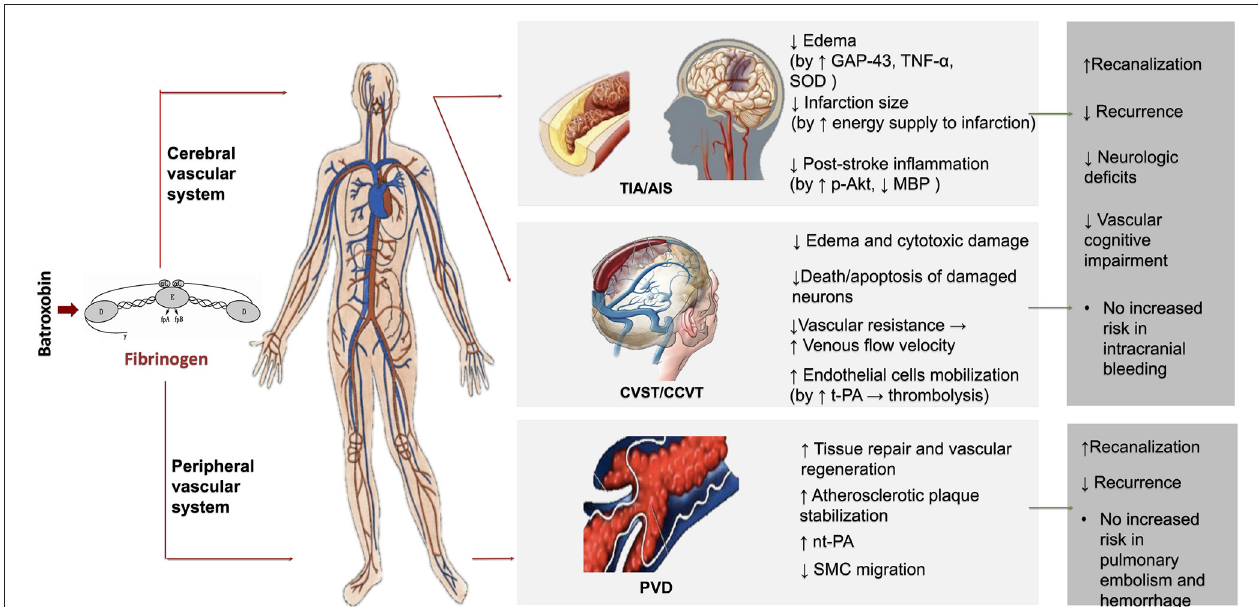
FIGURE 2 | The possible mechanisms and clinical application of batroxobin. TIA, Transient ischemic attack; AIS, Acute ischemic stroke; CVST, Cerebral venous sinus thrombosis; CCVT, Cerebral cortical vein thrombosis; PVD, Peripheral vascular disease; GAP-43, Growth-associated protein-43; TNF- α , Tumor necrosis factor alpha; SOD, Superoxide dismutase; nt-PA, Native tissue type plasminogen activator; MBP, Maltose-binding protein; p-Akt, Phospho-Akt (Ser473); SMC, Smooth muscle